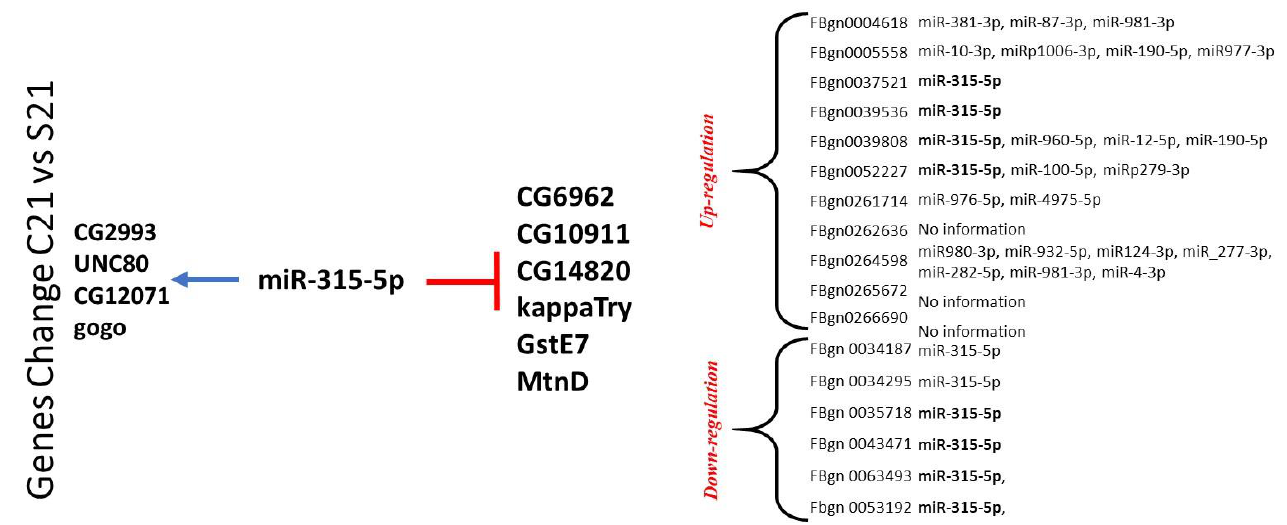
Figure 4. All of the genes analyzed had potential targeting sites by different microRNAs. The frequency of miR-315-5p in the gene list was highest and, notably, evolutionarily conserved among multiple Drosophila species unlike any other microRNAs studied. The involvement in miR-315-5p suggests several potential targets.